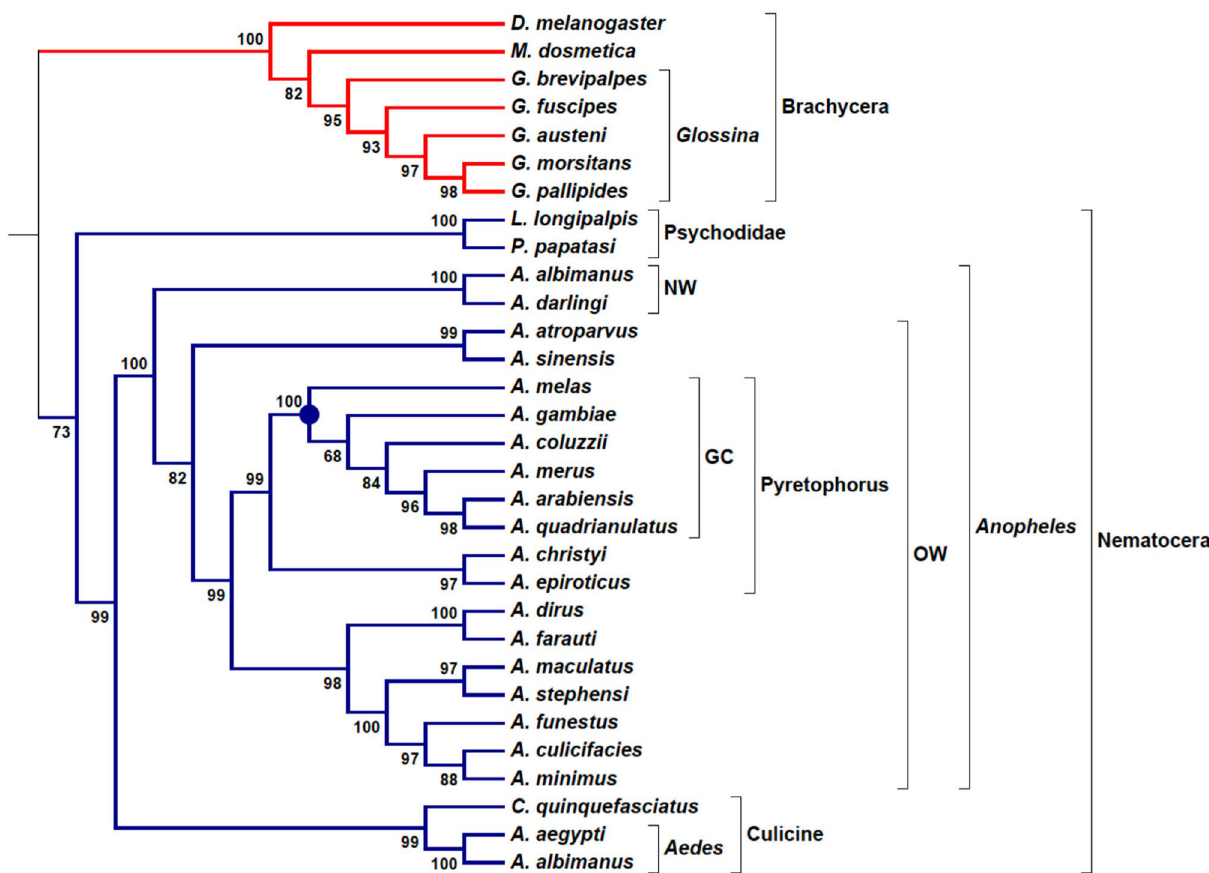
Figure 3. Phylogenomic tree of hematophagous Diptera. Phylogram constructed with the TOMM approach using approximately 8168 orthologous protein pairs across 31 Diptera species with genome sequence available (Table 2 and Supplemental Table S2). Numbers next to the branches represent the percentages of approximate unbiased support probabilities for 10,000 bootstraps, calculated using the pvclust 82 package in R (R Core Team. R: A language and environment for statistical computing. R Foundation for Statistical Computing, Vienna, Austria, 2018, URL: https ://www.R-proje ct.org/). The Newick file was annotated using the program MEGA 6. NW New World, OW Old World, GC gambiae